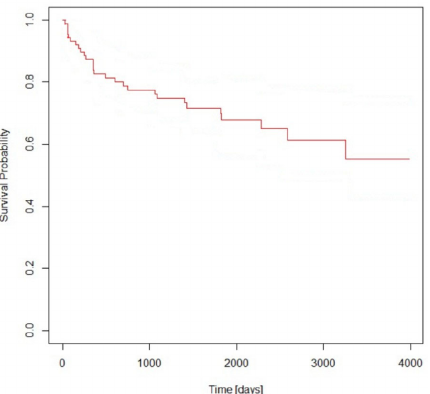
Figure 1. Kaplan–Meier curve for NOAF during STEMI